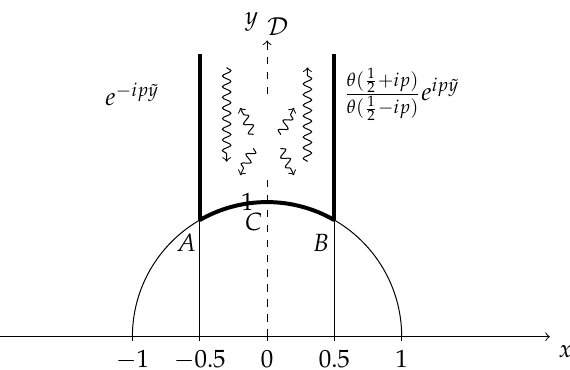
Figure 2. The incoming and outgoing plane waves (3). The plane wave e − ip ˜ y incoming from infinity of the y axis (the vertex D ) elastically scatters on the boundary ACB of the fundamental triangle AB D which defines the fundamental region F (see also Figure 1). The reflection amplitude is a pure phase and is given by the expression in front of the outgoing plane wave e ip ˜ y . The rest of the wave function describes the standing waves in the x direction between boundaries x = ± 1/2 with the amplitudes, which are exponentially decreasing.